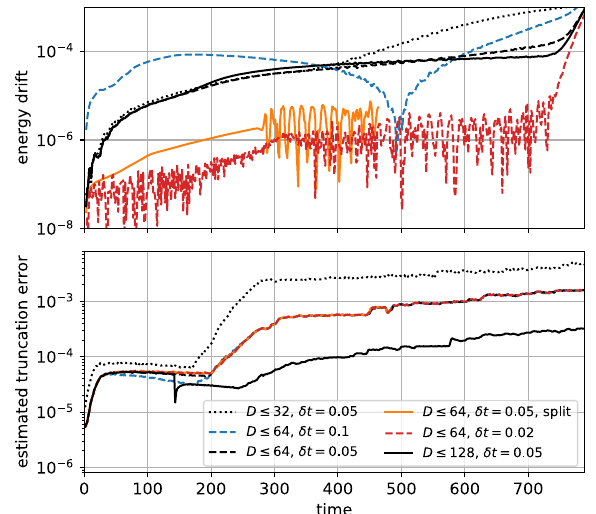
FIG. 20. Evolution of the energy expectation value and MPS truncation error for simulation (ii) of the main text. We com- pare different maximum bond dimensions D as well as different RK4 time-step sizes δ t (shown here in unscaled lattice Hamil- tonian units, for D ≤ 64), observing that the effects of the time step are most noticeable in the energy drift, whereas the bond dimension most obviously affects the truncation error at around the time of the first collision ( t ≈ 240). The D ≤ 128 simulation is initialized from D ≤ 64, δ t = 0.05 at t ≈ 142. The uptick in the energy drift at t ≈ 750 is due to unconfined wavepackets hitting the boundaries of the simulation window.